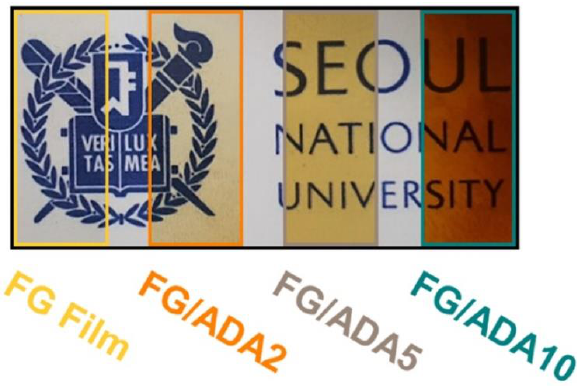
Figure 3. Optical properties of fish gelatin (FG)/alginate dialdehyde (ADA) composite films. Re- produced with permission from [13]. (Copyright 2020 Elsevier).